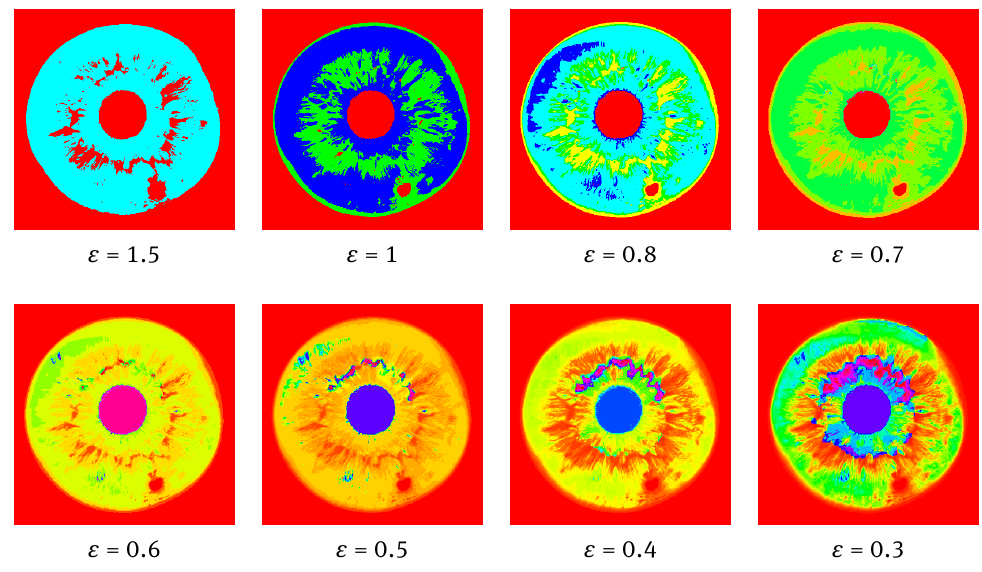
Figure 2: Visualizing of the ngbhSystem for various epsilon values